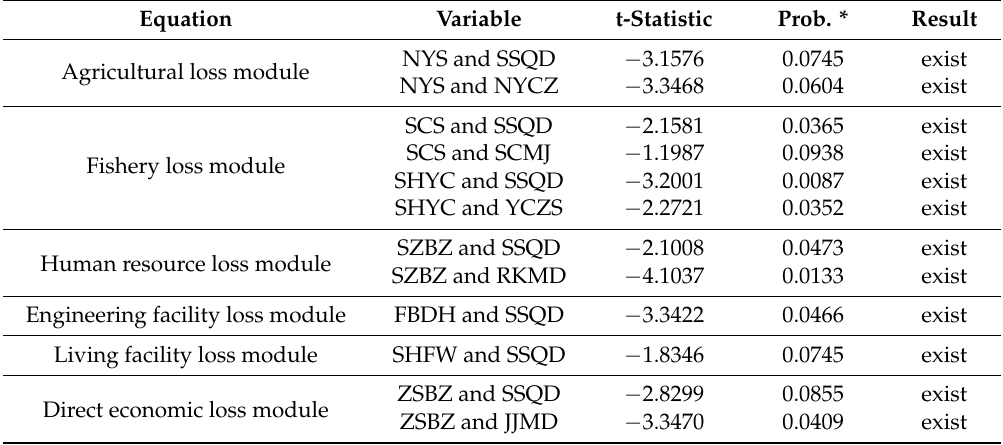
Table 7. The Engle–Granger (EG) cointegration test for the equations of storm surge disaster loss. Equation Variable t-Statistic Prob. * Result NYS and SSQD − 3.1576 0.0745 exist Agricultural loss module NYS and NYCZ − 3.3468 0.0604 exist SCS and SSQD − 2.1581 0.0365 exist SCS and SCMJ − 1.1987 0.0938 exist Fishery loss module SHYC and SSQD − 3.2001 0.0087 exist SHYC and YCZS − 2.2721 0.0352 exist SZBZ and SSQD − 2.1008 0.0473 exist Human resource loss module SZBZ and RKMD 0.0133 exist Engineering facility loss module FBDH and SSQD − 3.3422 exist Living facility loss module exist Direct economic loss